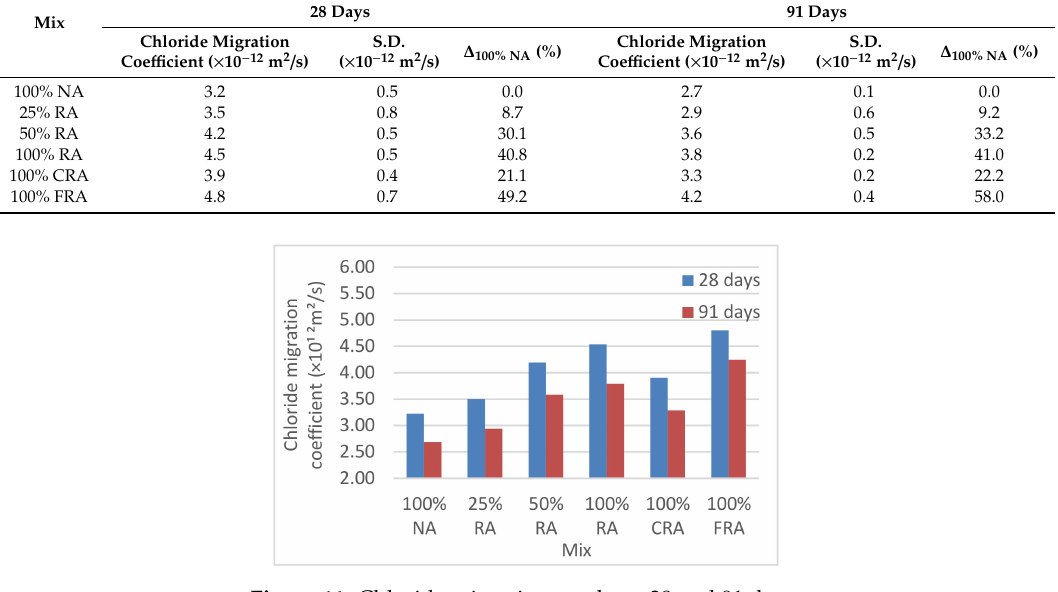
Figure 11. Chloride migration results at 28 and 91 days.